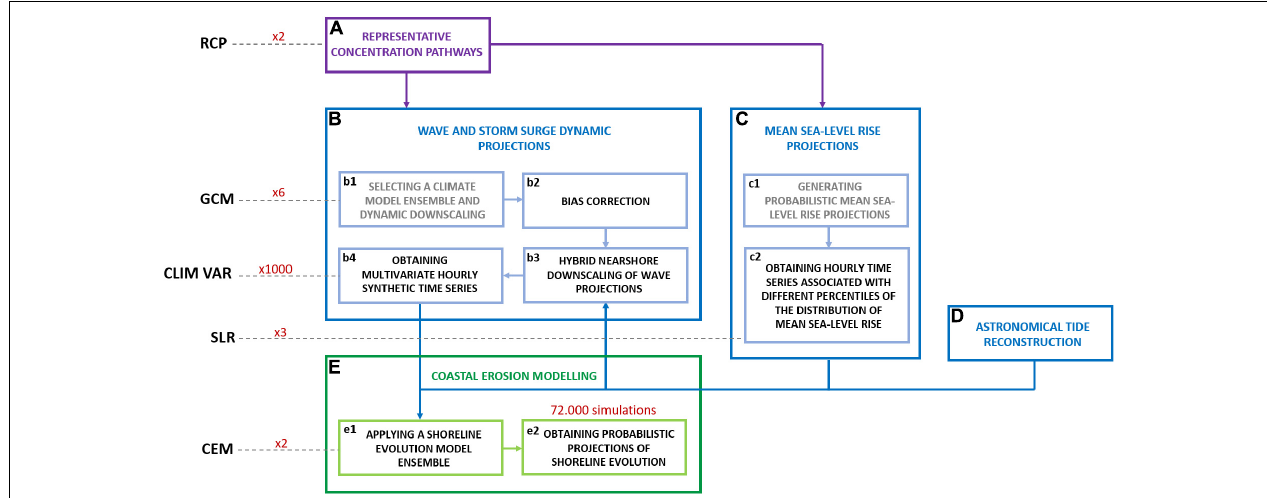
FIGURE 1 | Flowchart describing the methodology proposed for the development of coastal erosion projections. Boxes A–E represent different components of the top-down approach and, in particular, boxes A (RCP ensemble), b2 (GCM ensemble), b5 (internal climate variability sampling denoted as CLIM VAR), c2 (SLR percentiles), and e1 (CEM ensemble) relate to the different levels of the cascade of uncertainty. Actions displayed in grey colour involve actions not undertaken in this study although used as input for other steps.